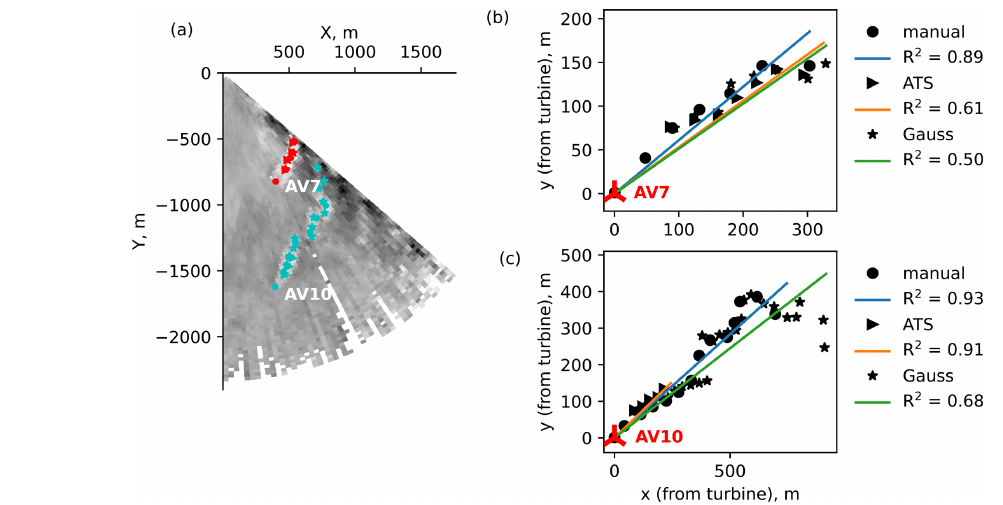
Figure 18. Scan 59 (parallel-wake subset). (a) An overview of the detected centerlines and regression fits for (b) AV7 and (c) AV10.